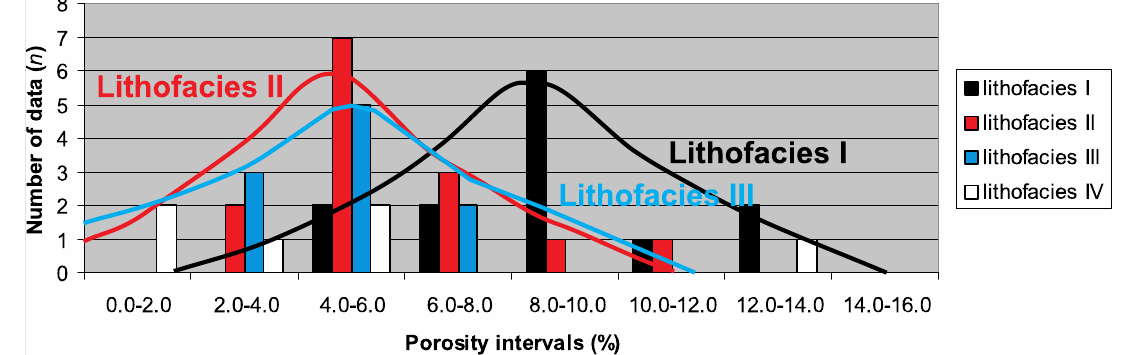
Figure 14. Histograms of interval porosity values in the lithofacies of the Molve structure. The lithofacies I-III could be approximated by the Gaussian distribution [44].